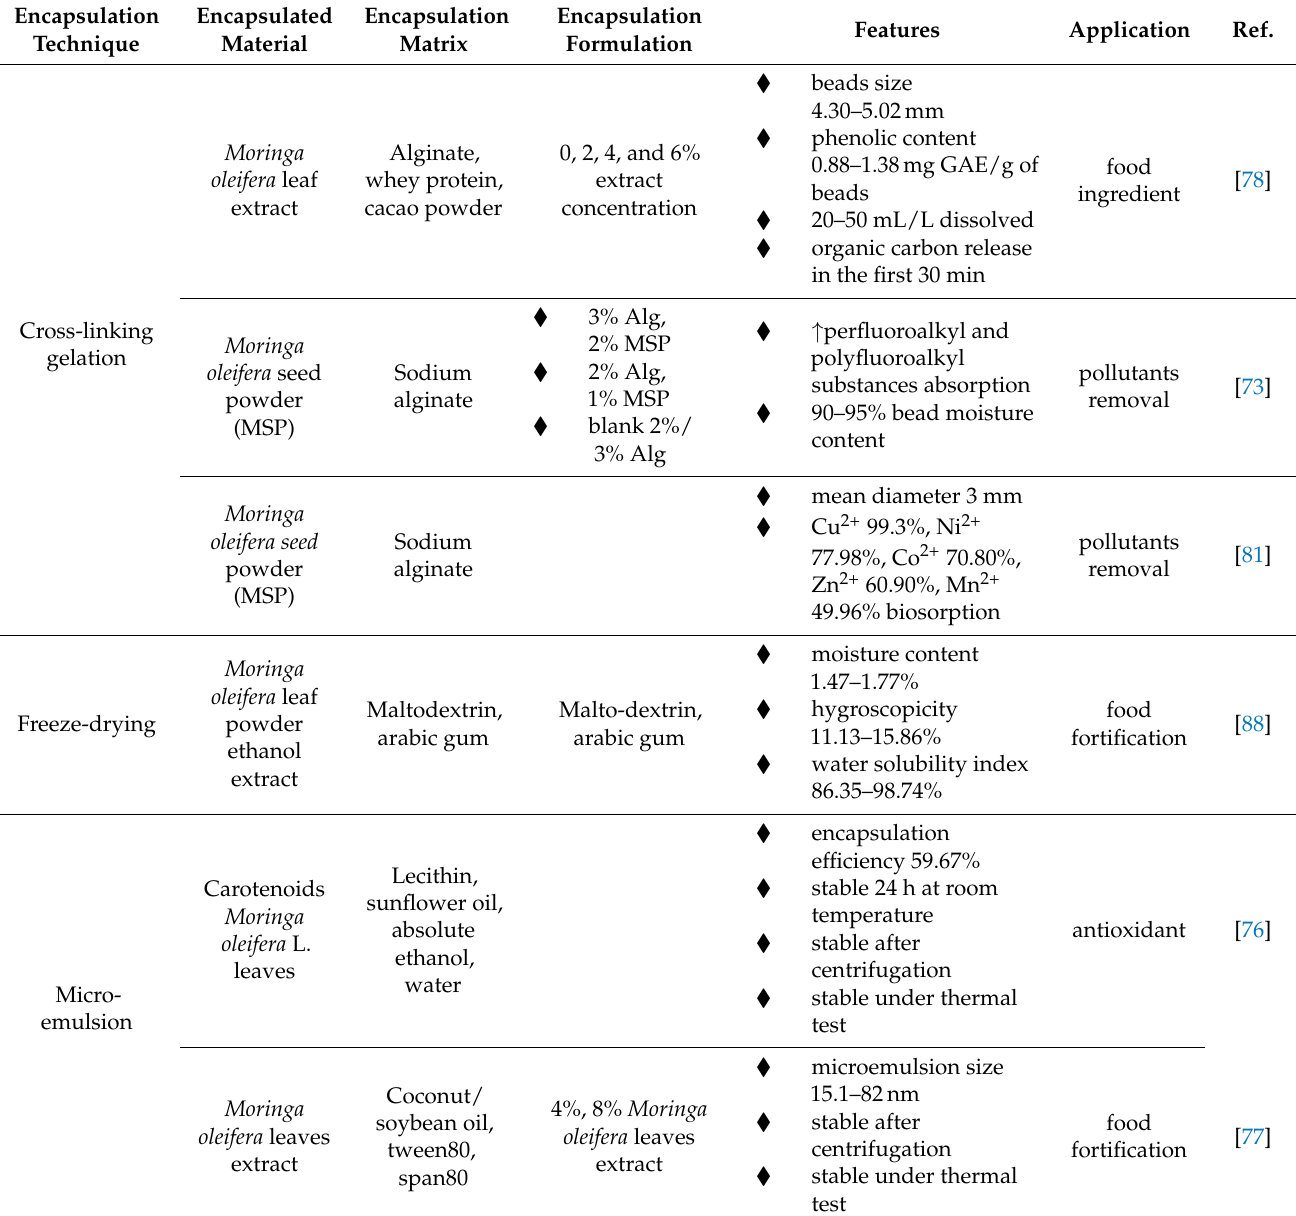
Table 1. Moringa oleifera bioactive compounds encapsulation techniques and features of the encapsu- lated